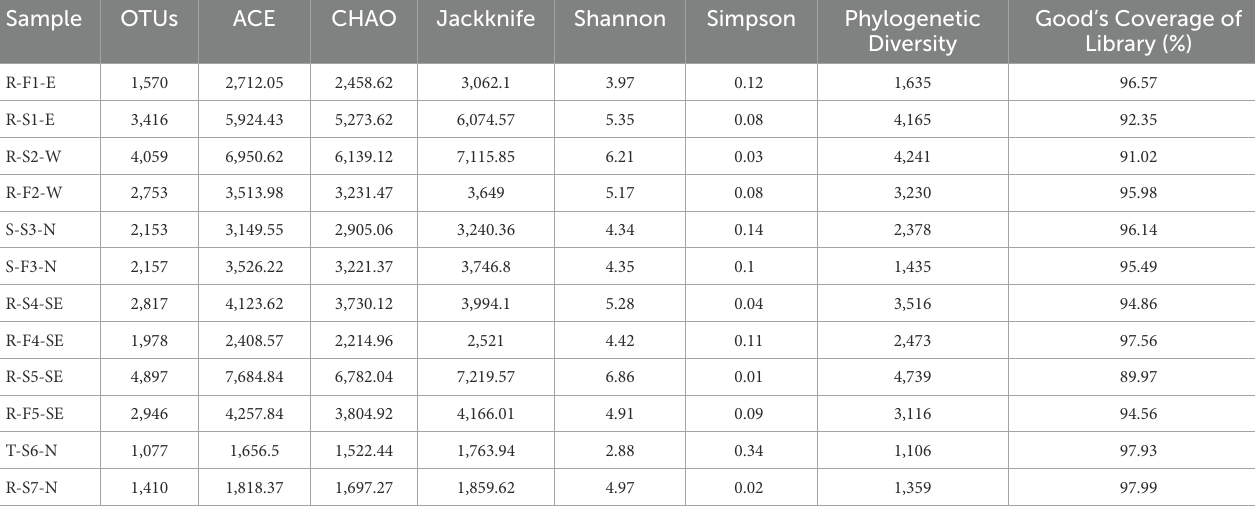
TABLE 1 List of total number of OTUs and calculated diversity analysis.